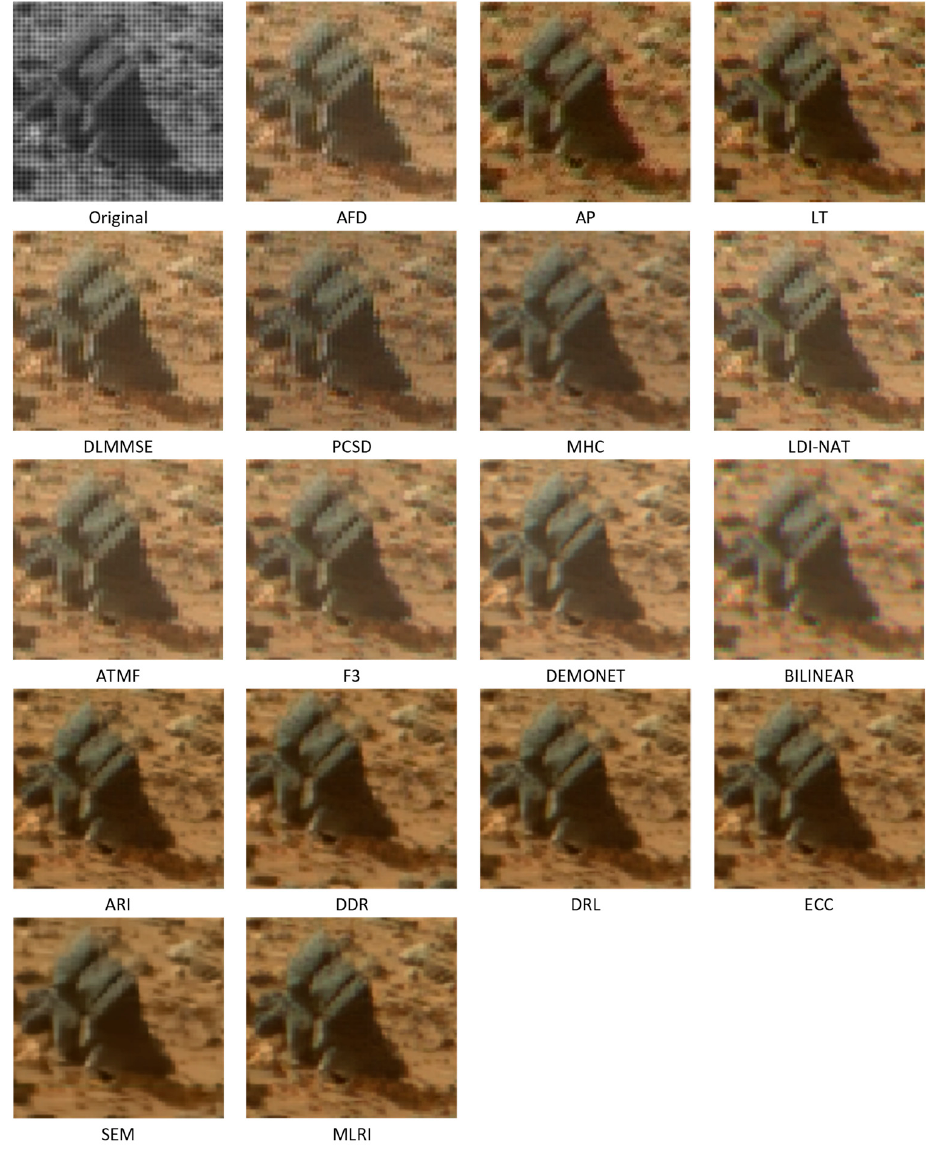
Figure 12. Demosaiced images of right Mastcam image 7.